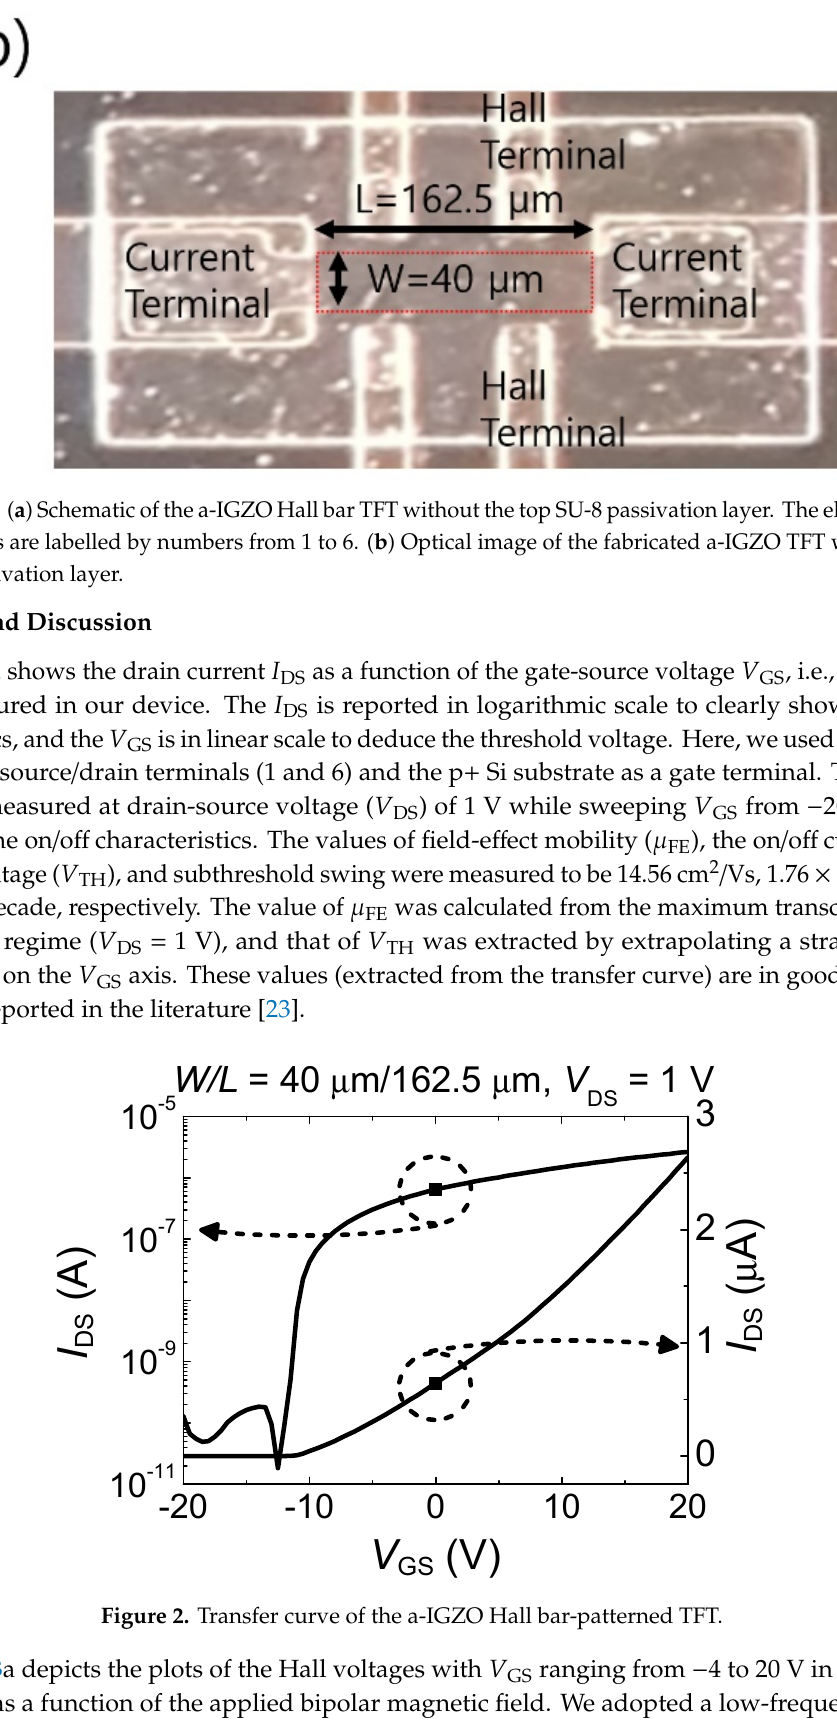
Figure 2. Transfer curve of the a-IGZO Hall bar-patterned TFT.